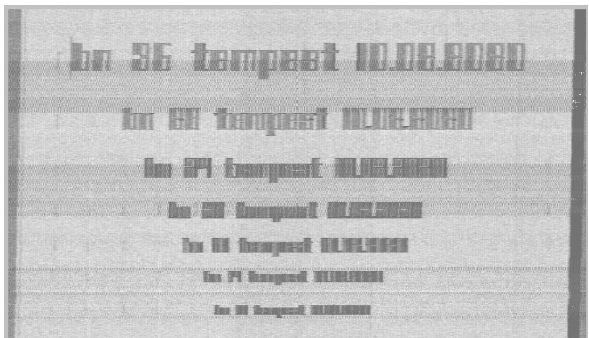
Figure 8. Image recovered when secure asymmetrical font was displayed—R&S FSET receiver. Appl. Sci. 2020 , 10 , x FOR PEER REVIEW